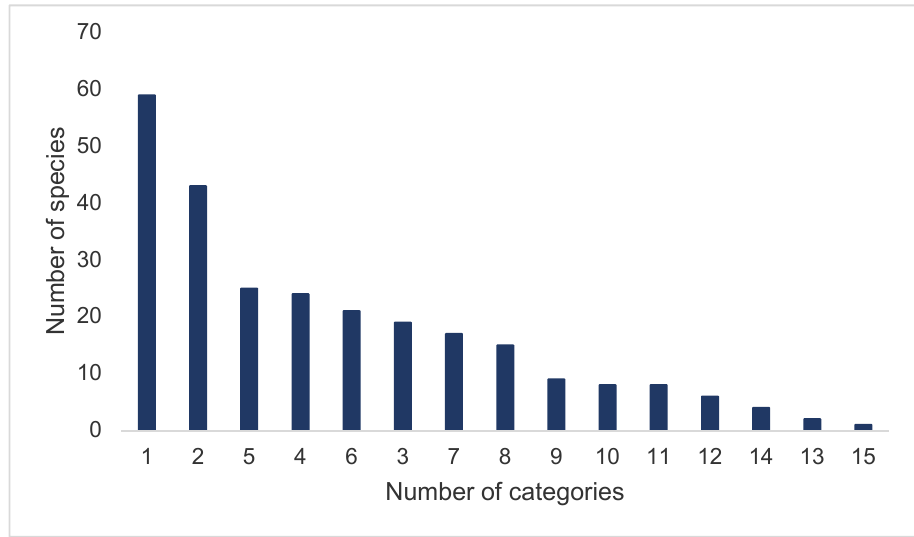
Figure 6. Numbers of medicinal legume species in Thailand and the numbers of categories in which they were used to treat disorders.